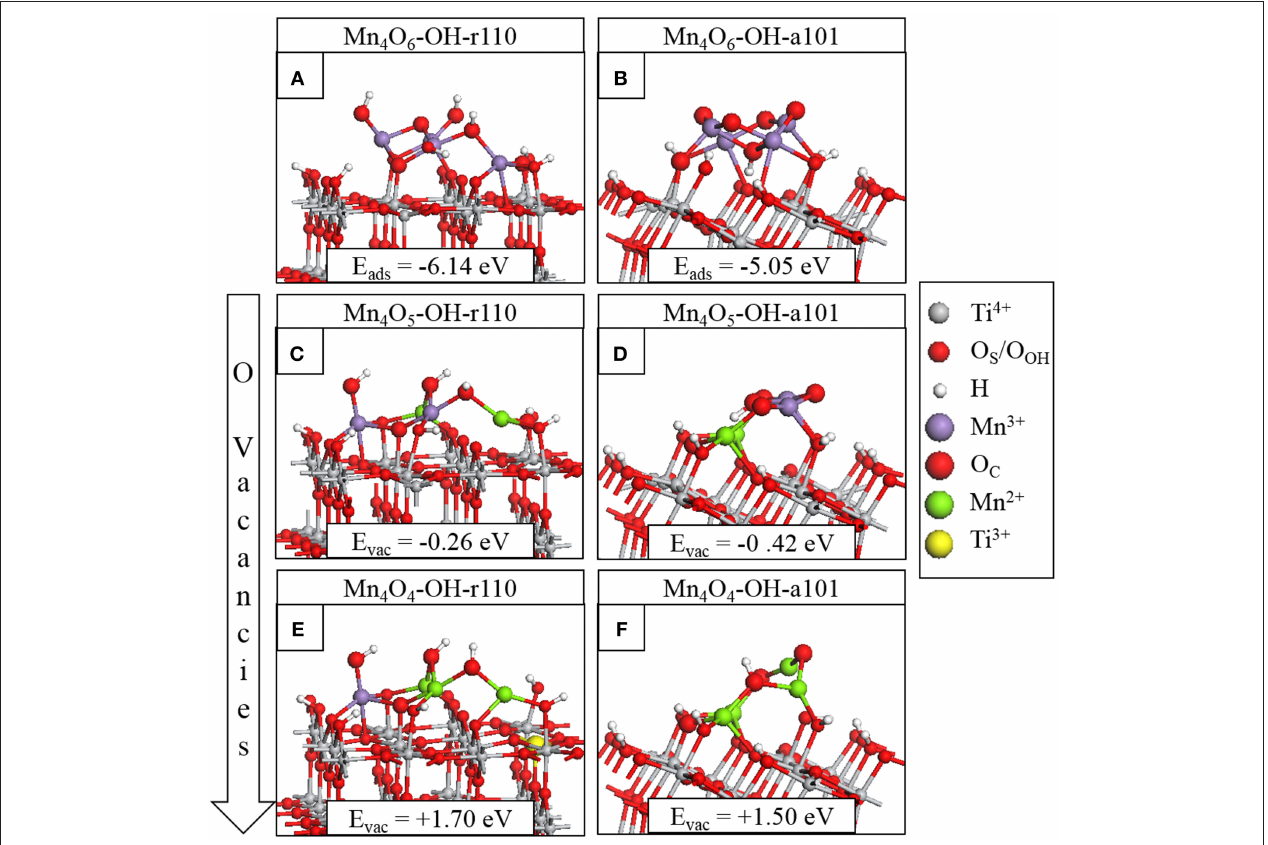
FIGURE 1 | Relaxed atomic structures of Mn 4 O x modifying the hydroxylated titania surfaces. The stoichiometric composites are shown in (A) for Mn 4 O 6 -OH-r110 and (B) for Mn 4 O 6 -OH-a101; the nanocluster adsorption energies are included in the inset. The atomic structures after formation of the most stable single O V are shown in panels (C) for Mn 4 O 5 -OH-r110 and (D) for Mn 4 O 5 -OH-a101. The atomic structures of the most stable composites with two O V are shown in panels (E) for